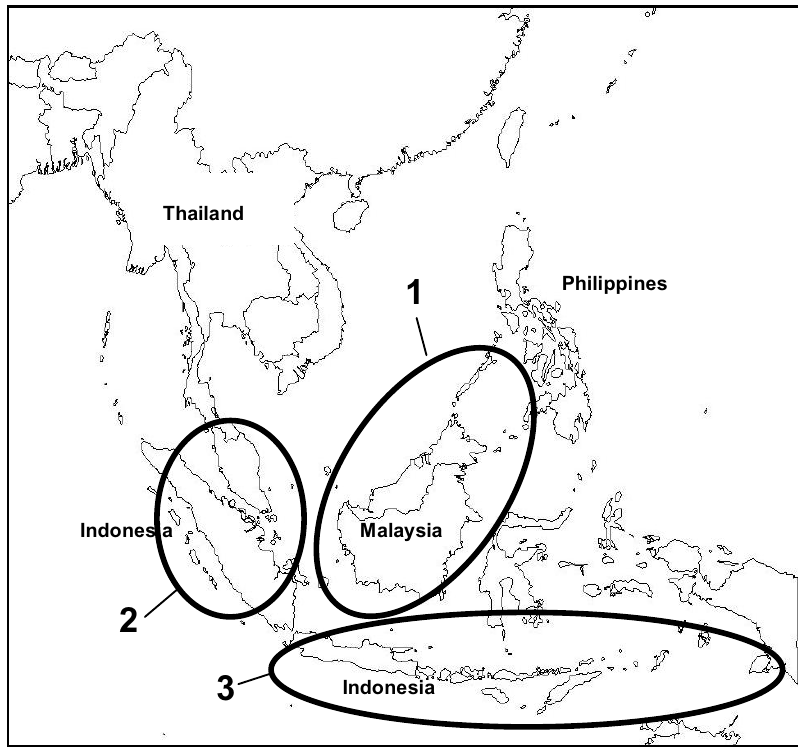
(Indonesia); ( 2 ) Malay Peninsula, Sumatra, and some Sulawesi; ( 3 ) Indonesia (Java, Bali, Irian Jaya, some Sulawesi and